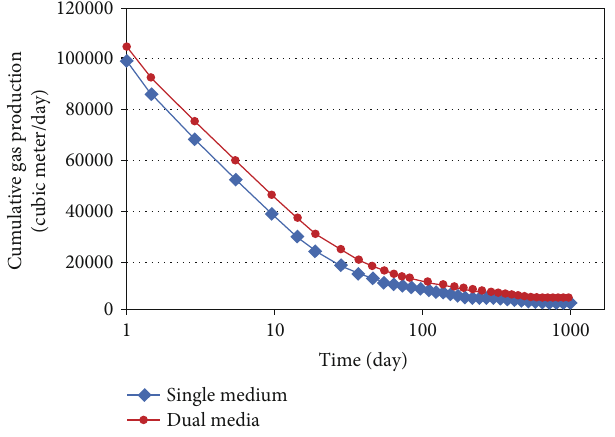
Figure 14: Comparison of gas production rate for a single medium and dual